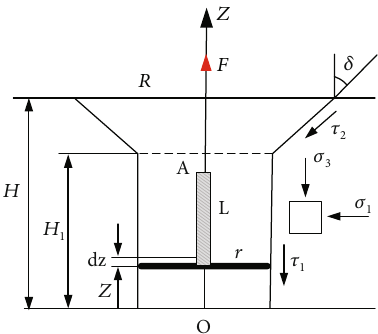
Figure 8: Medium (soil) and its shape when the anchor body is pulled out.